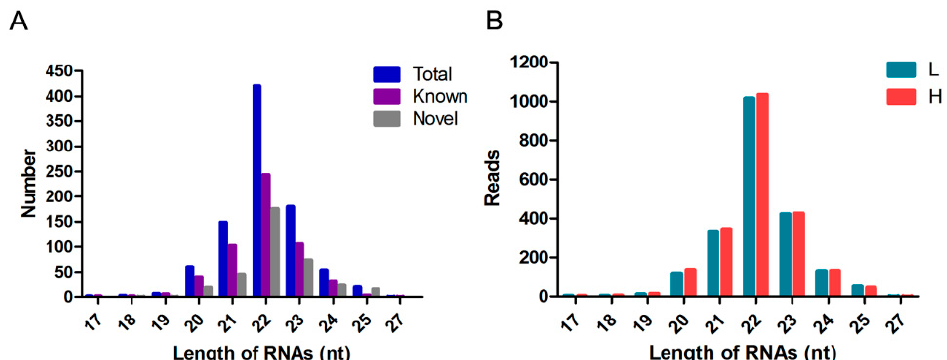
Figure 2. Summary of miRNA-seq data. ( A ) Distribution of miRNA sequences lengths (total, known, and novel). ( B ) Distribution of miRNA sequence reads between the H and L groups.